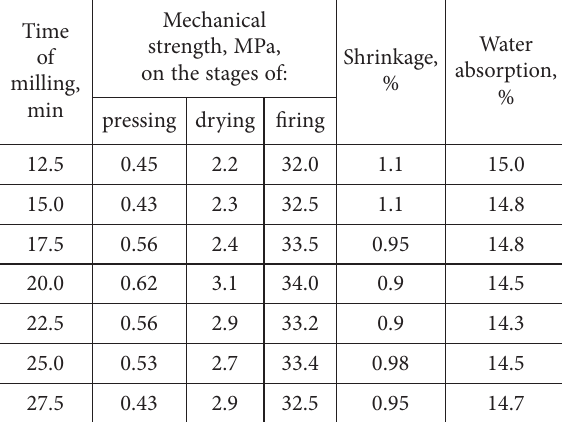
Table 2. Physico-chemical properties of semi-finished tiles and finished